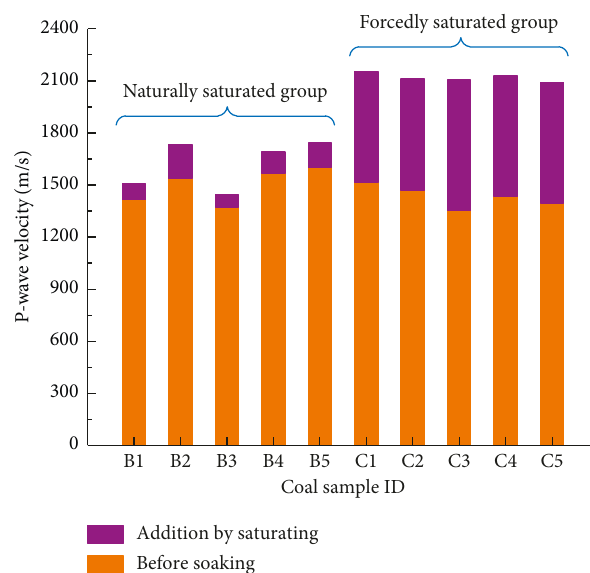
Figure 6: Bar graph of P-wave velocity characteristics of naturally and forcedly saturated coal